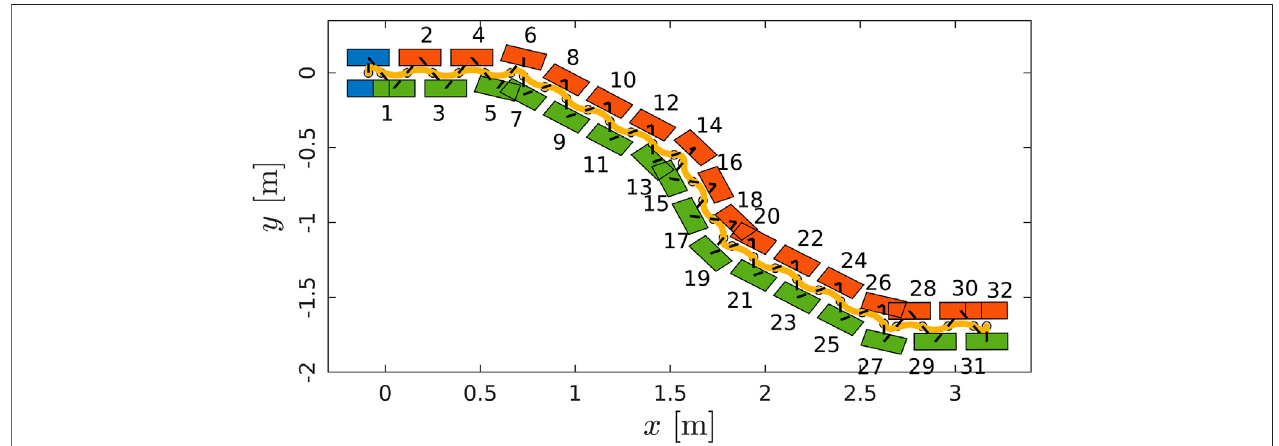
FIGURE 10 | Walking pattern consisting of the CoM trajectory (in yellow) and the footsteps (initial pose in blue, left and right soles in red and green respectively). COMAN+walks32 stepswitha0.28 mstep stride, 0.05 cmstep clearance and 0.4 sstep duration. Theheading changesof ϕ (cid:2) − 30 + at step 5and 13and of ϕ (cid:2) 30 + at step 19 and 27.